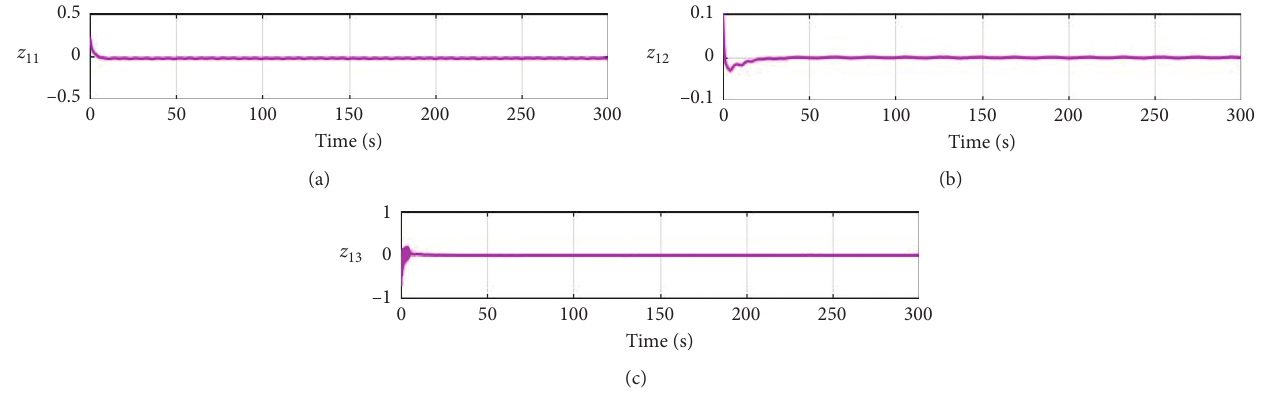
Figure 5: Trajectories of errors z